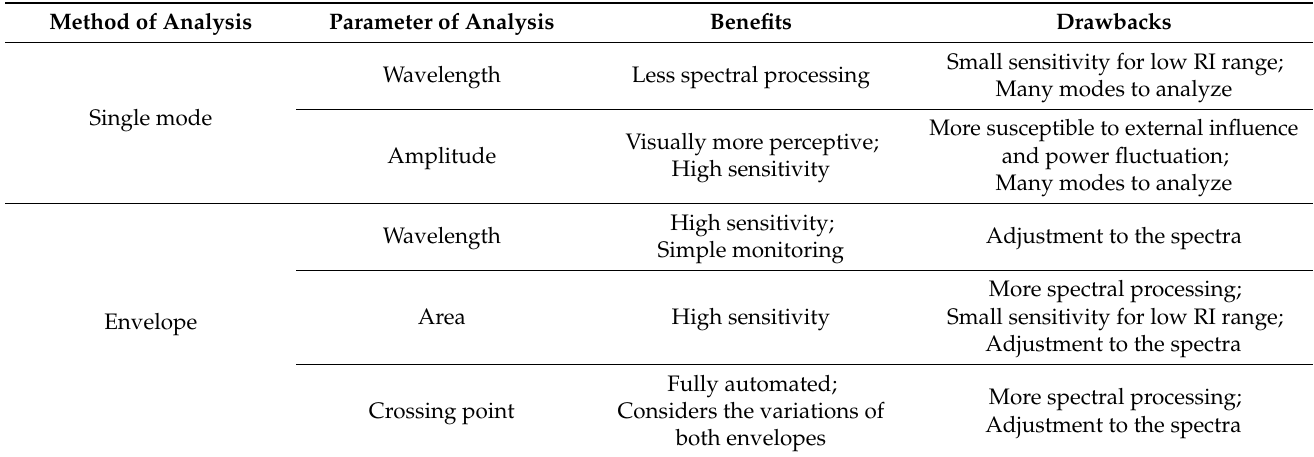
Table 2. Benefits and drawbacks of different methods of analysis [5,15,23,26,29]. Method of Analysis Parameter of